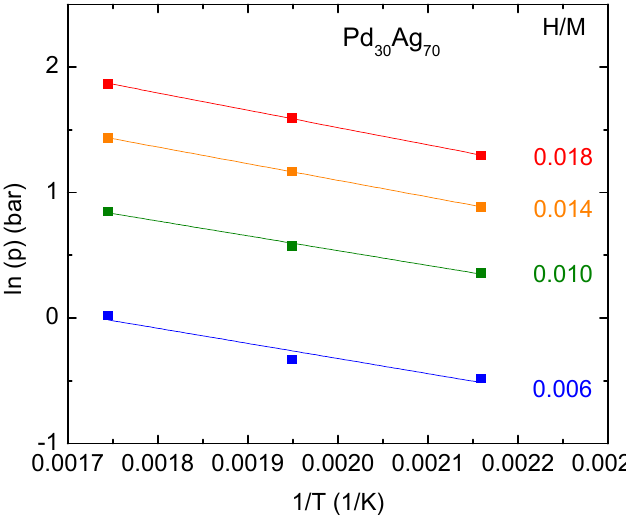
Figure 6. Van’t Hoff plot for Pd 30 Ag 70 at a fixed H/M in the whole concentration region and best fit lines.